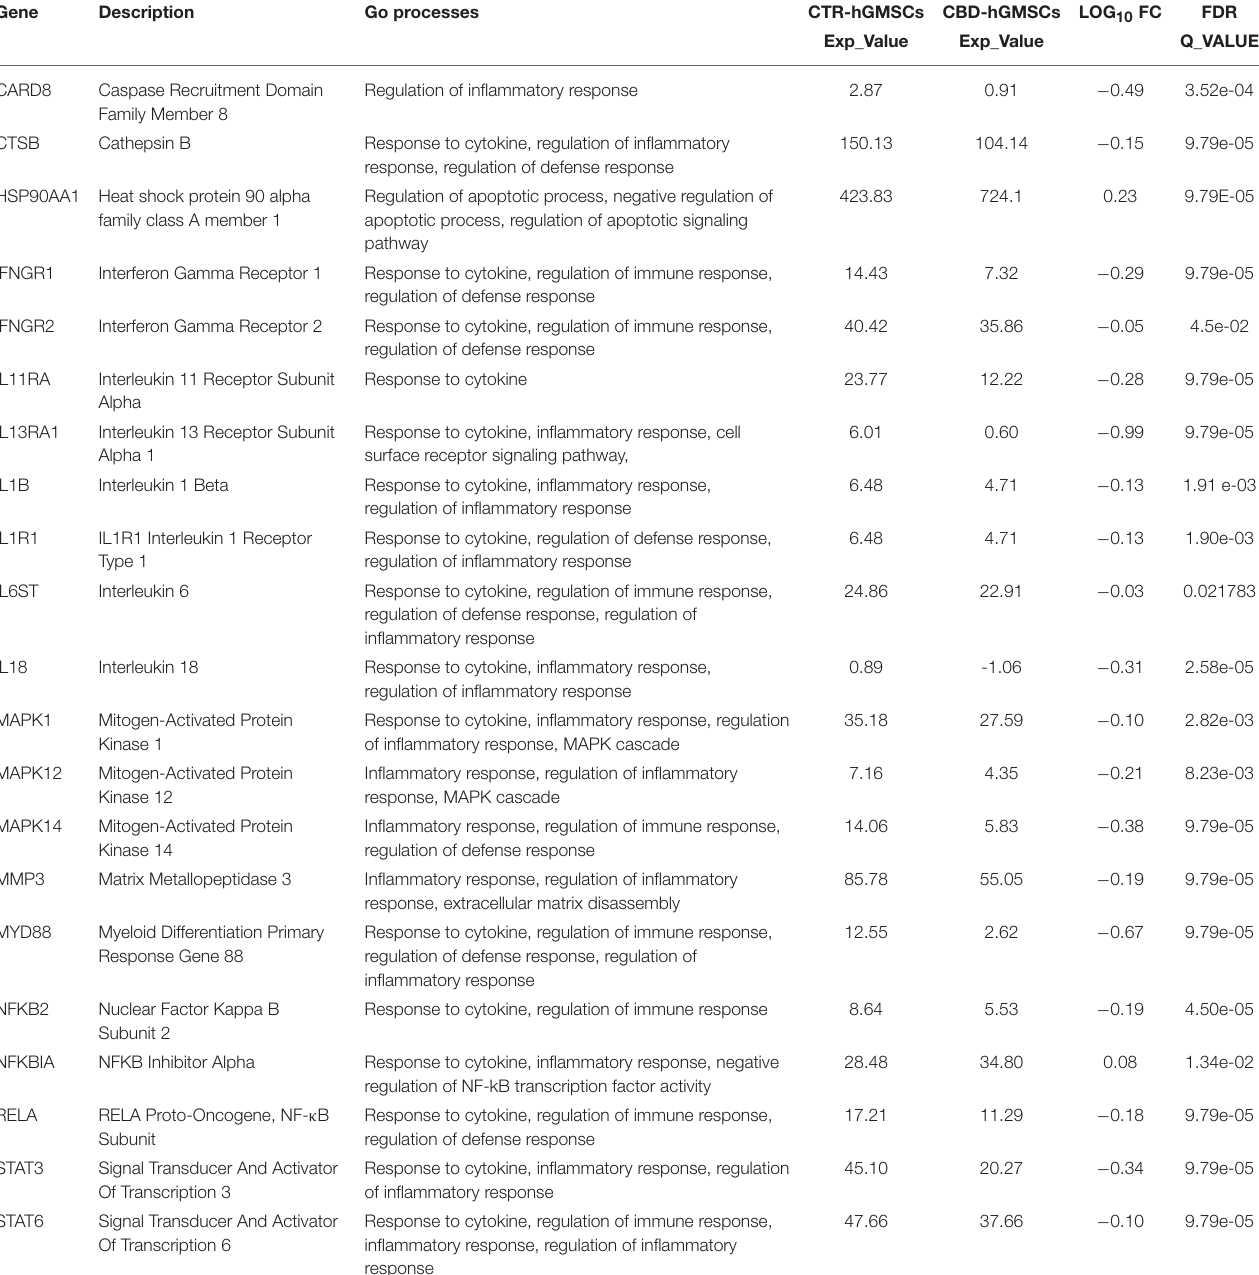
TABLE 2A | CBD treatment reduced the expression of pro-inflammatory genes. Gene